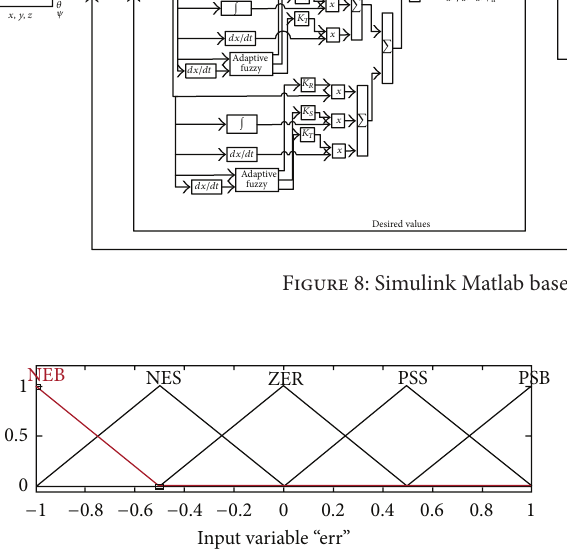
Figure 9: Membership function of fuzzy logic controller for input error.